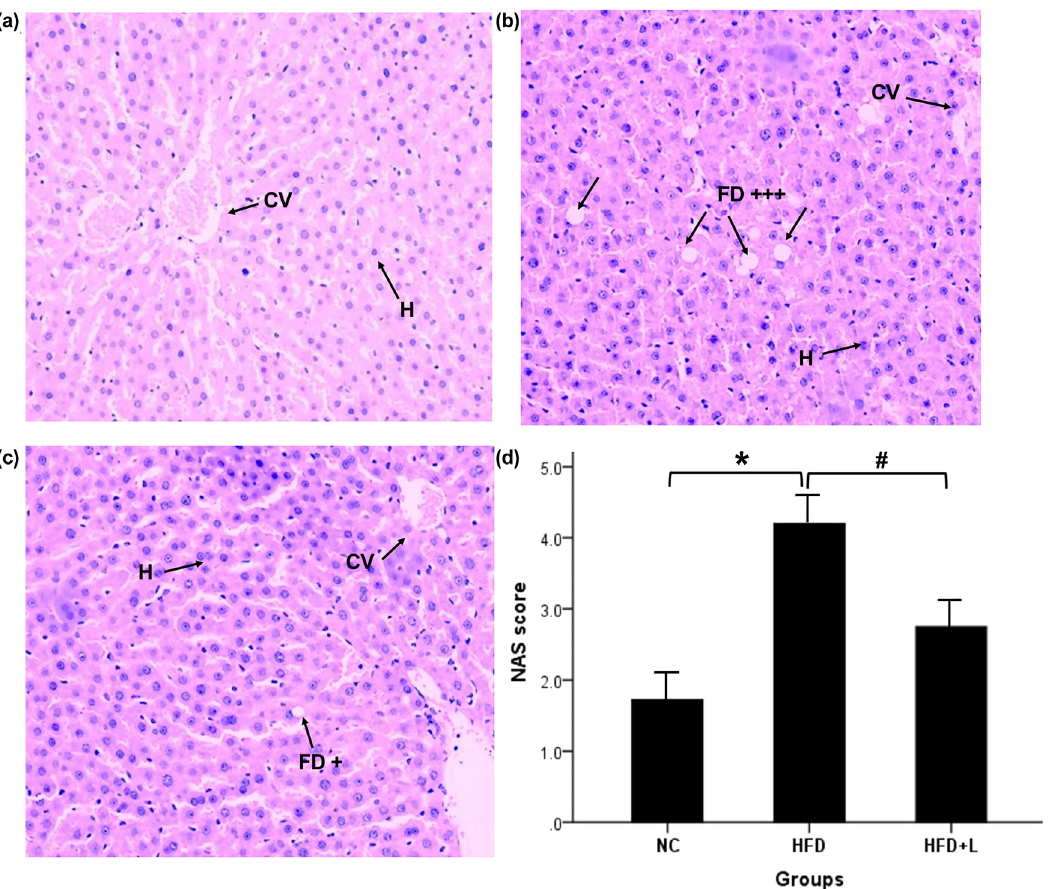
Figure 1: E ff ect of liraglutide on liver histopathology of rats fed HFD ( hematoxylin – eosin staining ) . Representative images for each group are shown ( magni fi cation 100 ×) . ( a ) Representative liver histopathology of rats in the normal control group ( normal hepatocytes and central vein are depicted ) . ( b ) Representative liver histopathology of rats fed HFD ( severe steatosis, fatty degeneration of hepatocytes, and